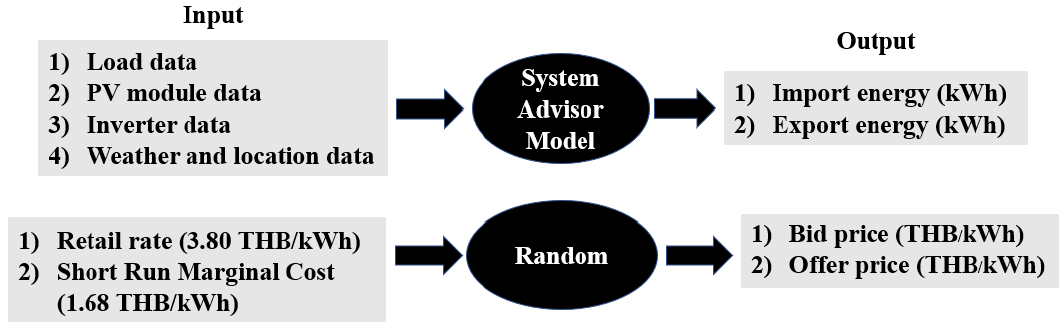
Figure 6. Creating sample data.